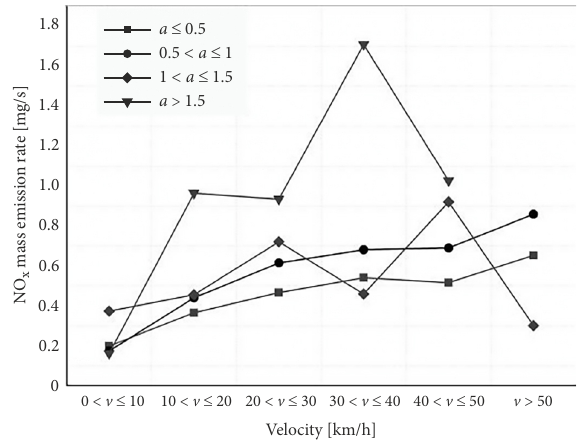
Figure 5. Effect of both velocity and acceleration on the mass emission rate of NO x